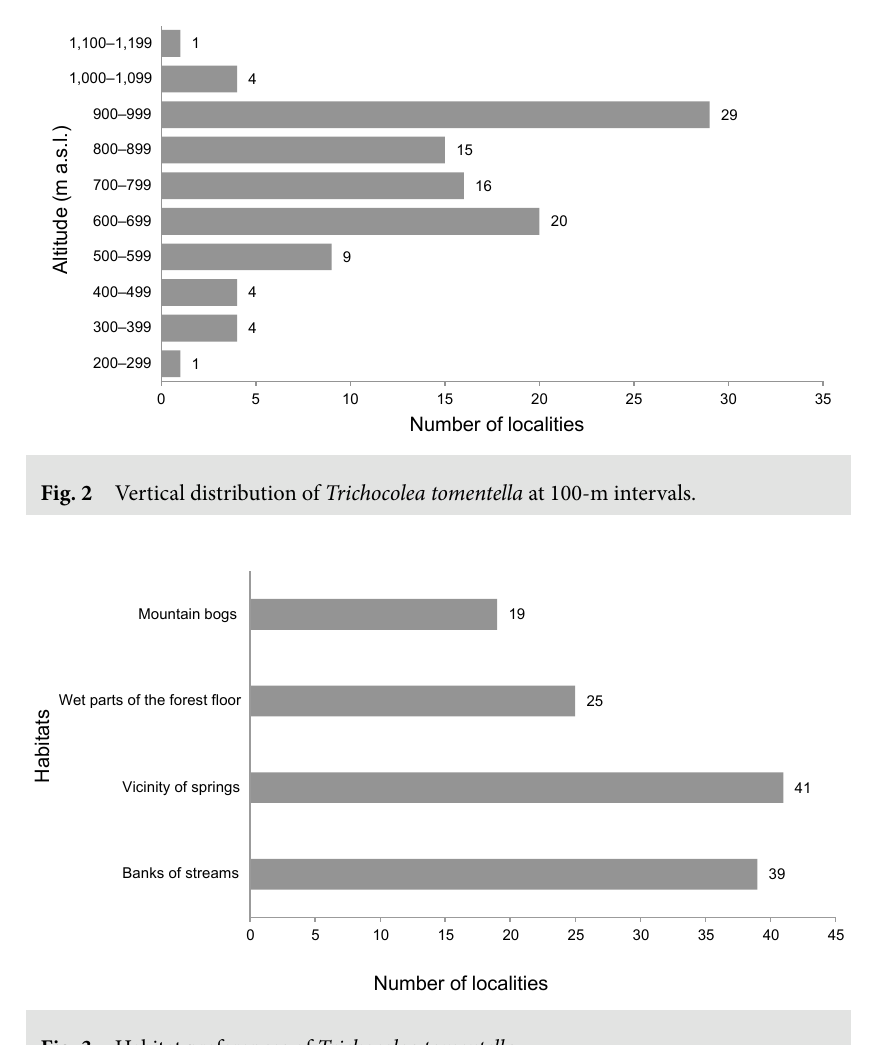
Fig. 3 Habitat preferences of Trichocolea tomentella